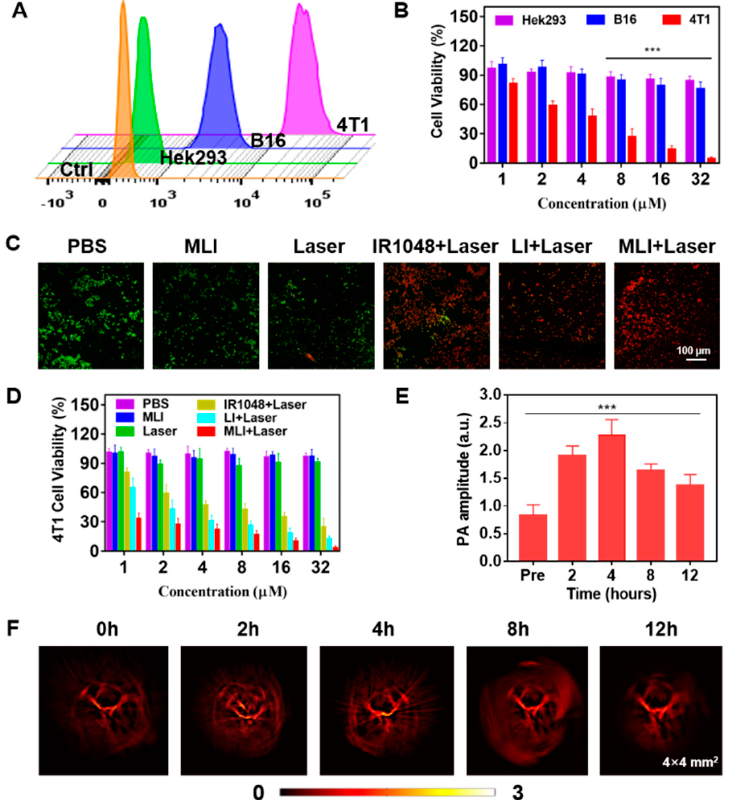
Figure 4. Cellular uptake, cytotoxicity and in vivo photoacoustic imaging. ( A ) Fluorescence intensity of MLI after incubation with various categories of cells for 4 h by flow cytometry. ( B ) Cytotoxicity investigation after treated with MLI with different concentrations upon 6 min 1064 nm laser irradi- ation. ( C ) Calcein-AM/PI (red: dead cells; green: live cells) dual-stained fluorescence images of 4T1 cells with various treatments. ( D ) 4T1 cell viability after different treatments with various concen- trations. ( E ) In vivo PA amplitude variation at various time. ( F ) PAI of tumor vasculatures at differ- ent time points before and after tail-vein injection of MLI. The PAI imaging regions were 4 × 4 mm 2 . *** p < 0.001.